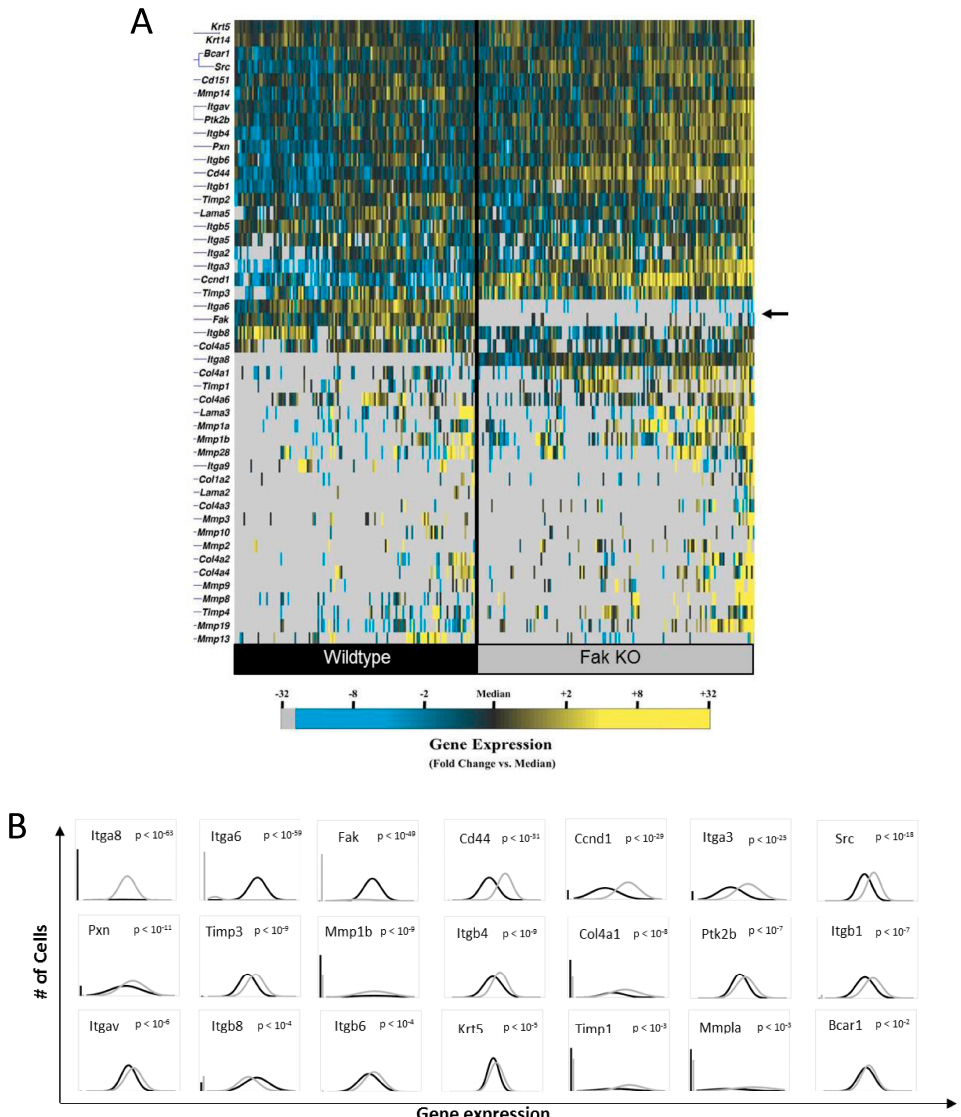
Figure 1. Keratinocyte FAK deletion alters the expression of numerous genes integral to tissue repair. ( A ) Hierarchical clustering of simultaneous gene expression for single cells from WT (left) and FAK KO (right) mice. Gene expression is presented as fold change from median on a color scale from yellow (high expression, 32-fold above median) to blue (low expression, 32-fold below median). Cell/gene qPCR reactions failing to amplify after 40 cycles are designated as non-expressers and represented in gray; ( B ) Differential gene expression between WT and FAK KO cells identified using nonparametric two-sample Kolmogorov-Smirnov testing. Twenty-one genes exhibit significantly different ( p < 0.01 following Bonferroni correction for multiple comparisons) distributions of single cell expression between populations, illustrated here using median-centered Gaussian curve fits. Black and gray color histogtams denote WT and FAK KO expression, respectively. The left bar for each panel represents the fraction of qPCR reactions that failed to amplify in each group.